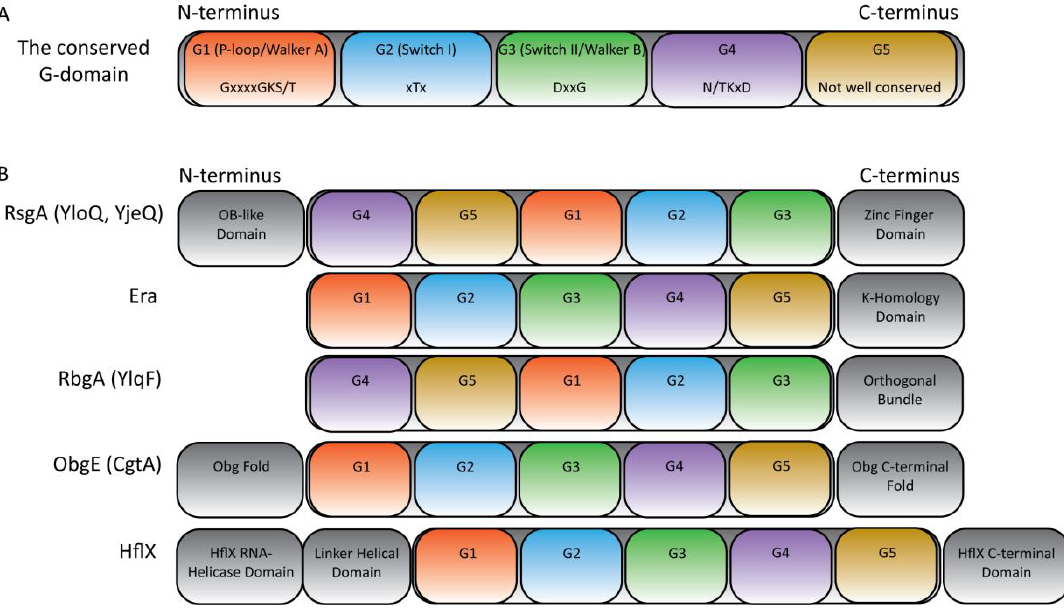
Figure 2. Domain structure of RA-GTPases inhibited by (p)ppGpp. ( A ) The general domain structure of the highly conserved GTPase domain, featuring the catalytic G1-G5 motifs is shown. Functions for these motifs include: G1 (P-loop, Walker A motif) binds and recognises the α - and β - phosphate of GTP; G2 and G3 (Switch I and Switch II / Walker B motif, respectively) stabilise the γ -phosphate of GTP through coordination of the Mg 2 + cofactor; G4 confers guanine specificity via π -stacking of the lysine residue with the guanine ring and specific H-bonding of the aspartate with the guanine amino groups; G5 interacts with the guanine via H-bonds, but is poorly conserved and not universally present among TRAFAC GTPases. Consensus sequences are highlighted. ( B ) The domain architecture of the TRAFAC GTPases mentioned in this review. Note the circular permutation of RsgA and RbgA.